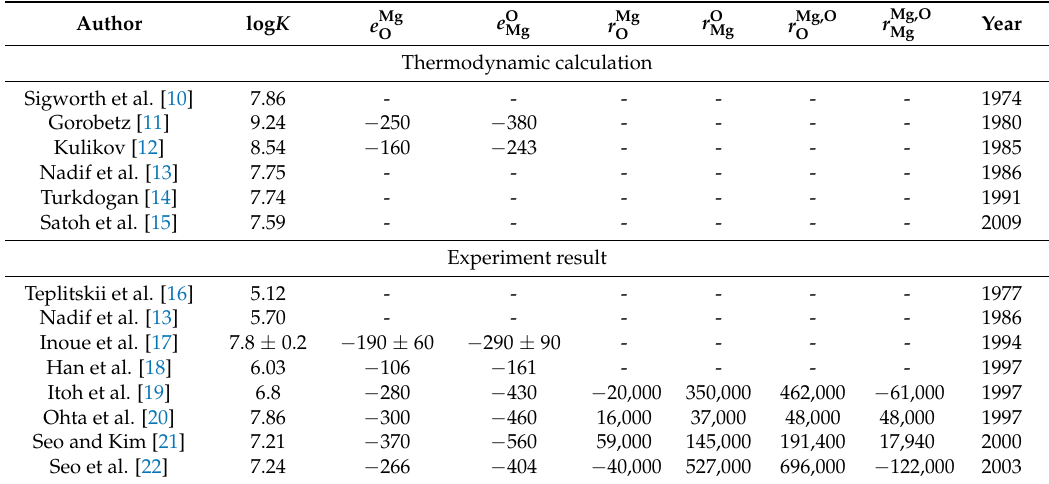
Table 1. Equilibrium constants and interaction coefficients of Mg-O system in liquid iron at 1873 K.